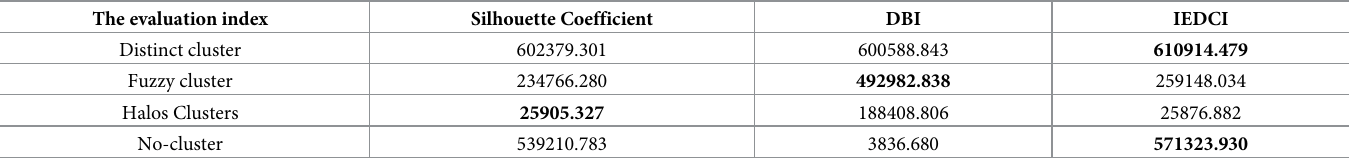
Table 7. Separation evaluation results of different performance